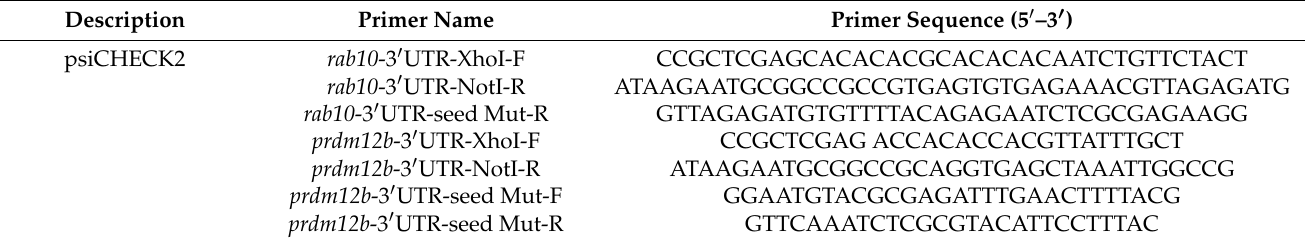
Table A1. Sequences of primer used in this